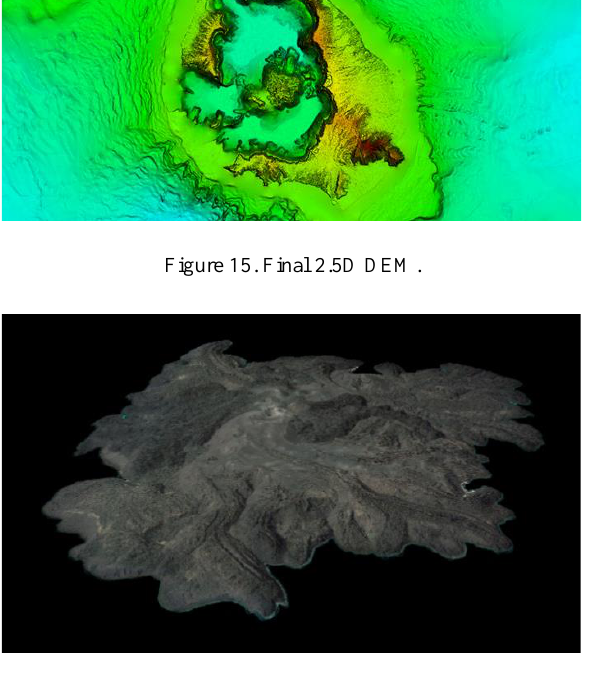
Figure 16. 2.5D colored terrain model of Kammeni island.